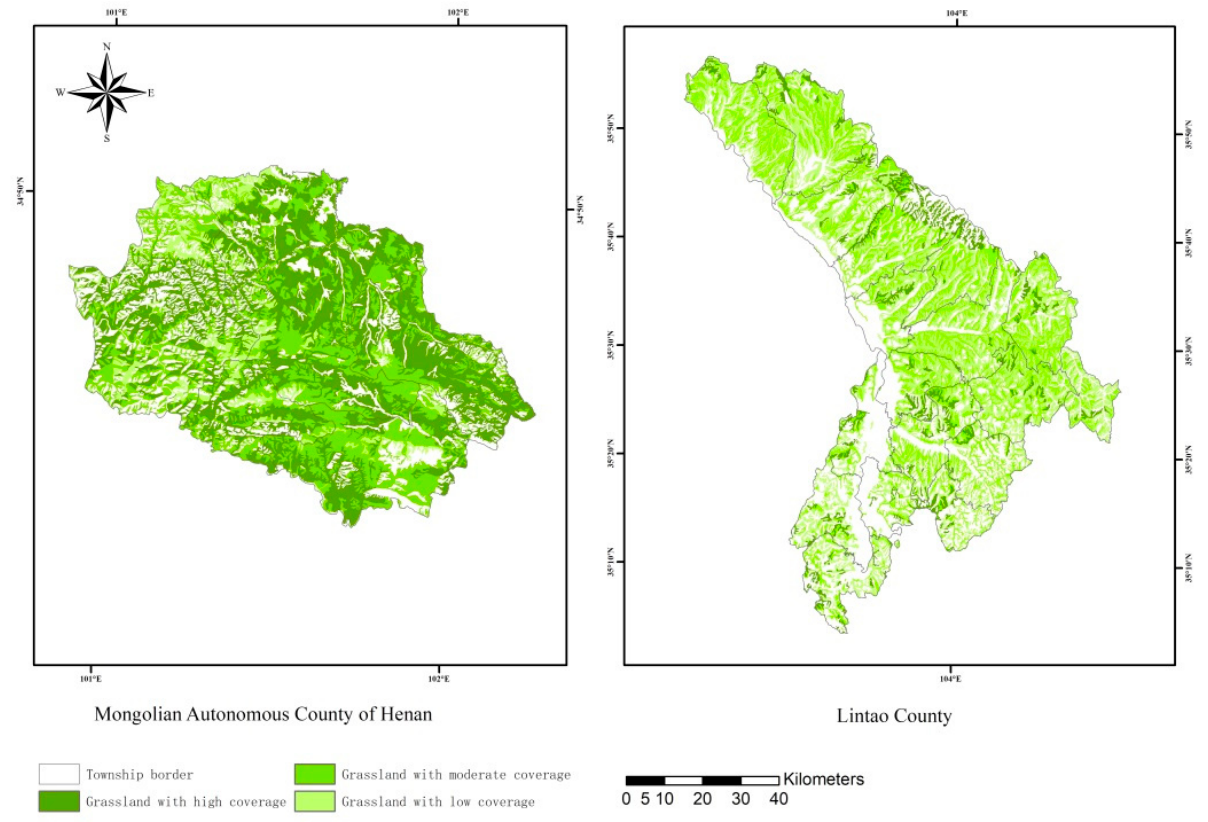
Figure 1. Location of the study areas.